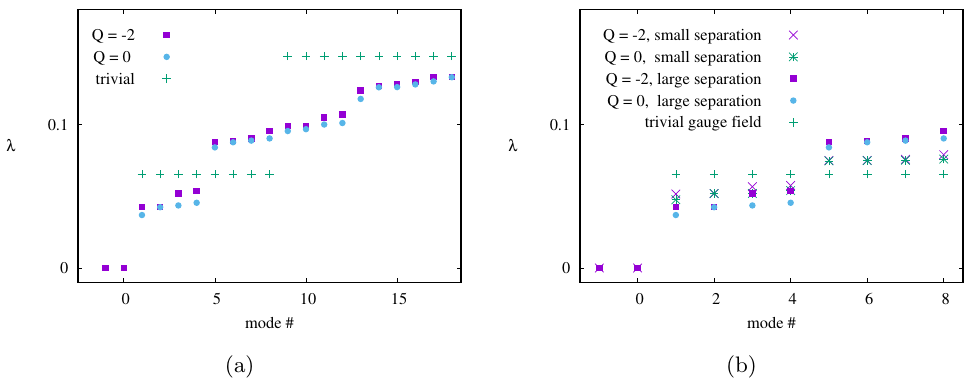
Figure 5 . (a) The lowest overlap eigenvalues for the vortex con(cid:12)gurations schematically displayed in (cid:12)gure 3 with Q = (cid:0) 2 ((cid:12)gure 3(a)) and Q = 0 ((cid:12)gure 3(b)). These values are compared with those of the free Dirac operator on a 16 4 lattice. (b) The in(cid:13)uence of the distance between the vortex sheets is investigated for the Q = (cid:0) 2 con(cid:12)guration. Increasing this distance the interaction decreases and the lowest lying non-zero modes move from the lowest Matsubara frequency towards